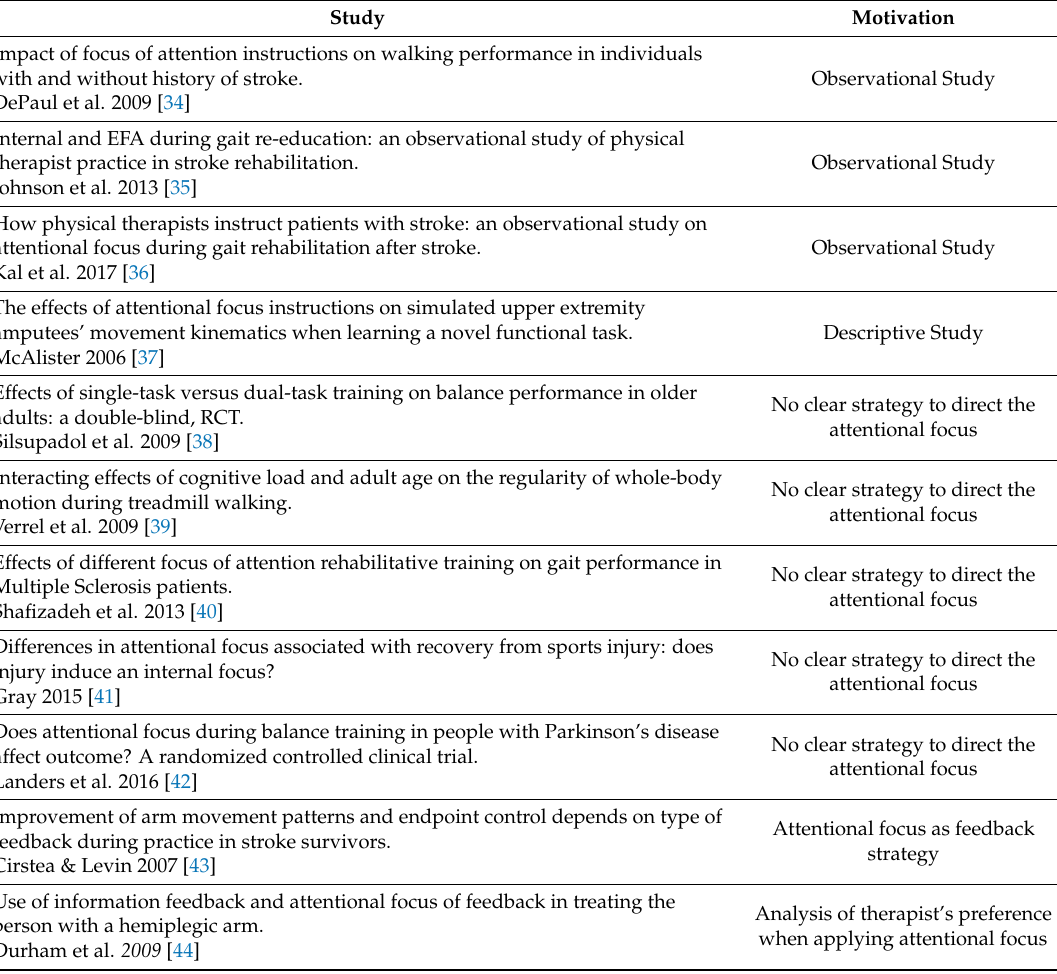
Table A1. Studies excluded with